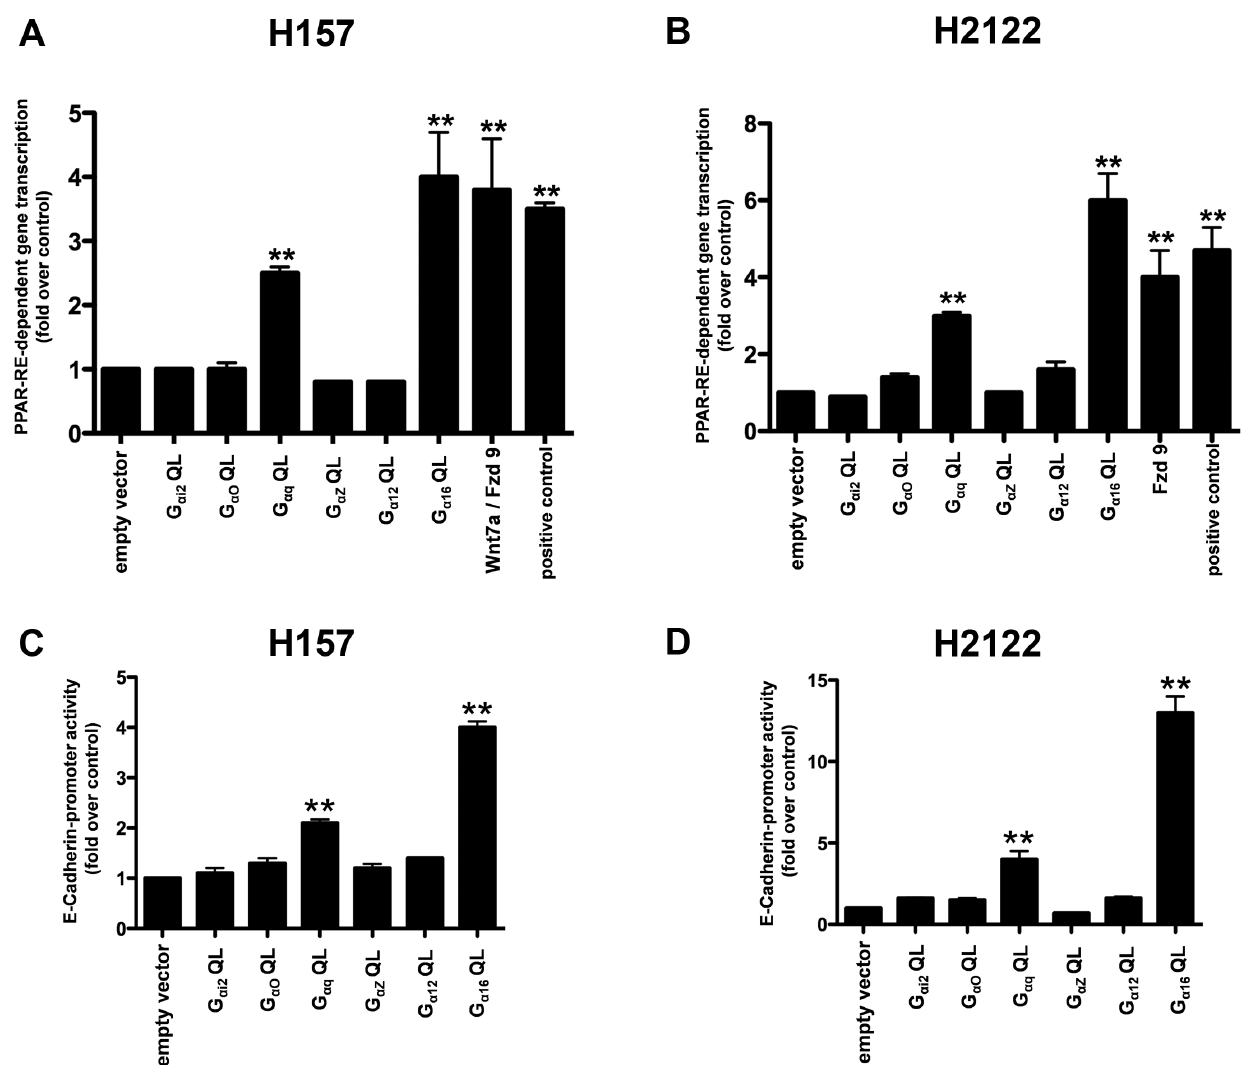
Figure 1. Identification of G a 16 as a novel downstream regulator of Wnt7a/Fzd9 signaling. Effects of constitutively active G a subunits on Wnt7a/Fzd9-dependent read-outs. NSCLC cell lines, H157 (A) or H2122 (B) were transfected either with empty vector, or constitutively active G a subunits of G-proteins together with PPAR-RE-luciferase reporter and CMV- b -galactosidase reporter vectors. After 48 h, the cells were lysed and luciferase activities were measured as described in the Methods. NSCLC cell lines, H157 (C) or H2122 (D) were transfected either with empty vector, or constitutively active G a subunits of G-proteins together with E-cadherin promoter-luciferase-reporter and CMV- b -galactosidase reporter vectors. After 48 h, the cells were lysed and luciferase activities were measured as described in the Methods. Luciferase values were normalized to CMV- b - galactosidase values and were represented in the graph. Constitutively active G a subunit-induced PPRE-dependent gene transcription or E-cadherin promoter activity were represented as the fold change over the empty vector control. Data represents mean 6 SEM of three separate experiments. **, p , 0.01; versus empty vector control.